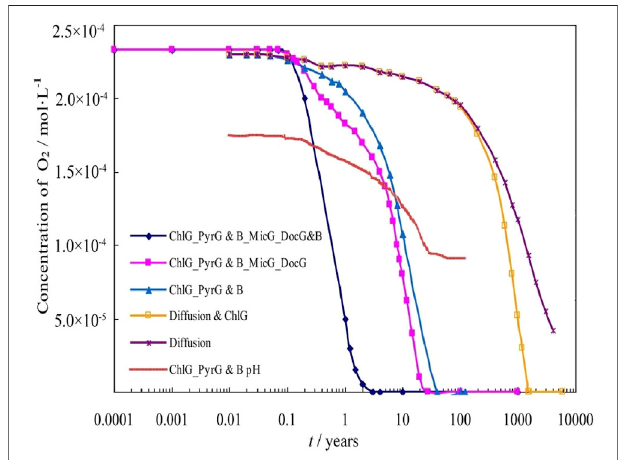
FIGURE 5 | Oxygen content evolution in different simulated